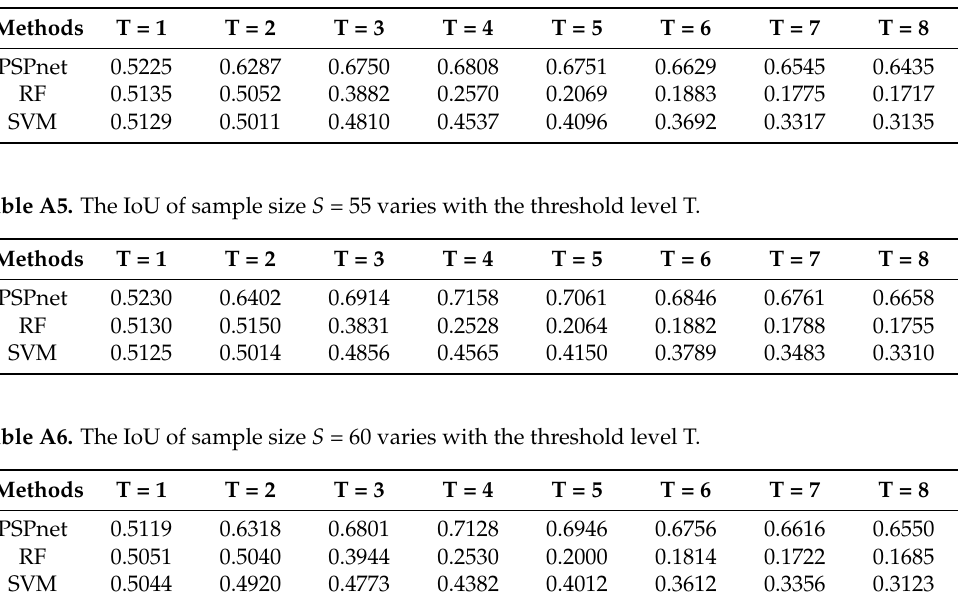
Table A4. The IoU of sample size S = 50 varies with the threshold level T.